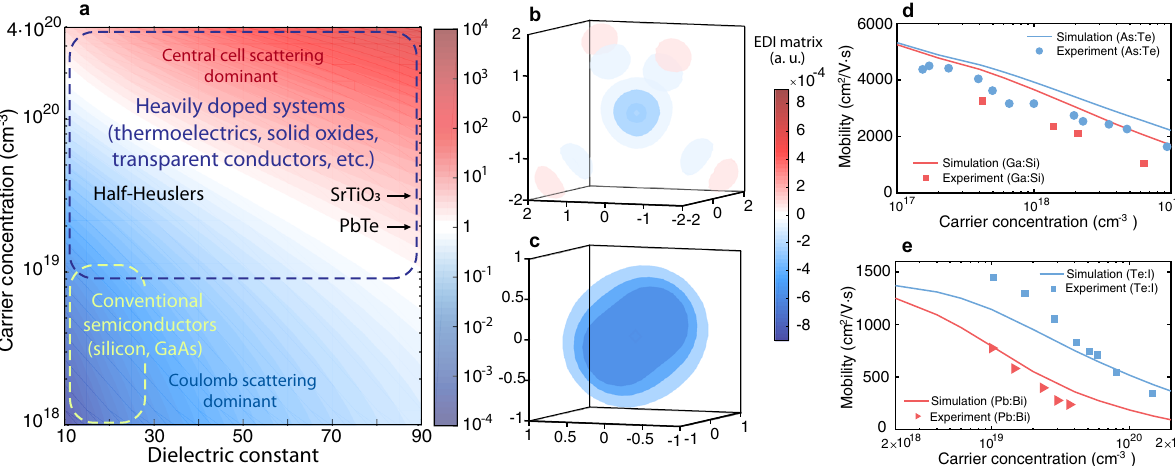
Fig. 2 Electron-defect interaction. a Ratio between characteristic electron scattering rates due to central cell scattering and those due to Coulomb = γ scattering, η ¼ γ , shown as a color map (with red indicating high η , blue indicating low η , and white indicating unity, as shown in the scale on the cent Coul right), with respect to the dielectric constant and carrier concentration. The characteristic electron scattering rate γ is de fi ned based on the mobility μ as γ ¼ e = ð m (cid:2) μ Þ . Studied materials in this work are also labeled in the plot. Both PbTe and SrTiO 3 have large dielectric constants and the arrows indicate their actual locations lie outside the given dielectric constant range. Regions with η (cid:3) 1 represent cases in which the central cell potential has a comparable impact on charge transport to that of the Coulomb potential, and thus could be harnessed to counteract the Coulomb scatterings. The magnitude of the central cell potential is taken to be 6 eV (with a width of 6 Bohr radius) in this simulation. b , c Contour plots of the electron-defect interaction matrix h ψ j4 b V j ψ i for ( b ) Si-doped GaAs and ( c ) Bi-doped PbTe, respectively, where ( k ) is taken to be at the conduction band edge state (at the Γ point for GaAs k k and at the L point for PbTe). Signi fi cant electron-defect interaction is seen for PbTe. The unit of the coordinates is Å and the center is at the defect location. d , e Computed electron mobility as a function of the carrier density for ( d ) n-type GaAs with two different dopants (Ga:Si, As:Te) and ( e ) n-type PbTe with two different dopants (Pb:Bi, Te:I) in comparison to experimental results [experimental sources: As:Te and Ga:Si 10 ; Te:I 41 ; Pb:Bi 42 ]. For PbTe, Bi doping strongly reduces the mobility compared to I doping, whereas the dopant effects on GaAs are comparatively